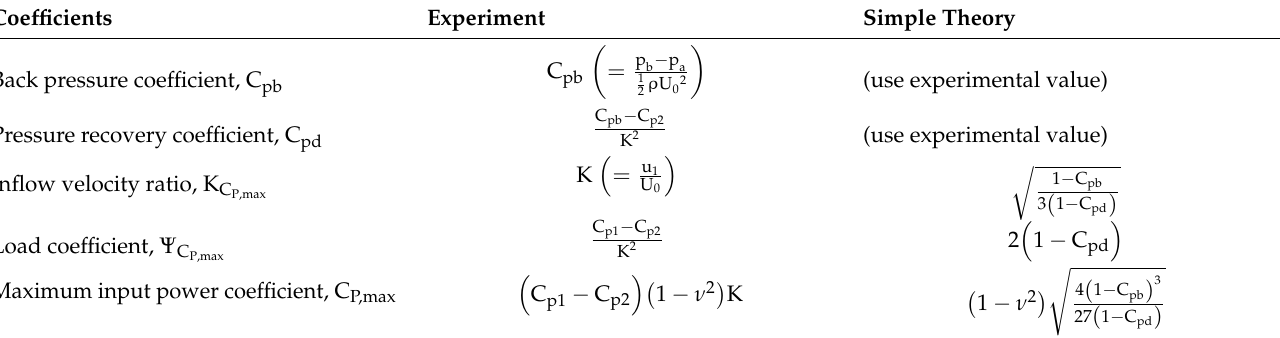
Table 1. Equations for calculating the performance